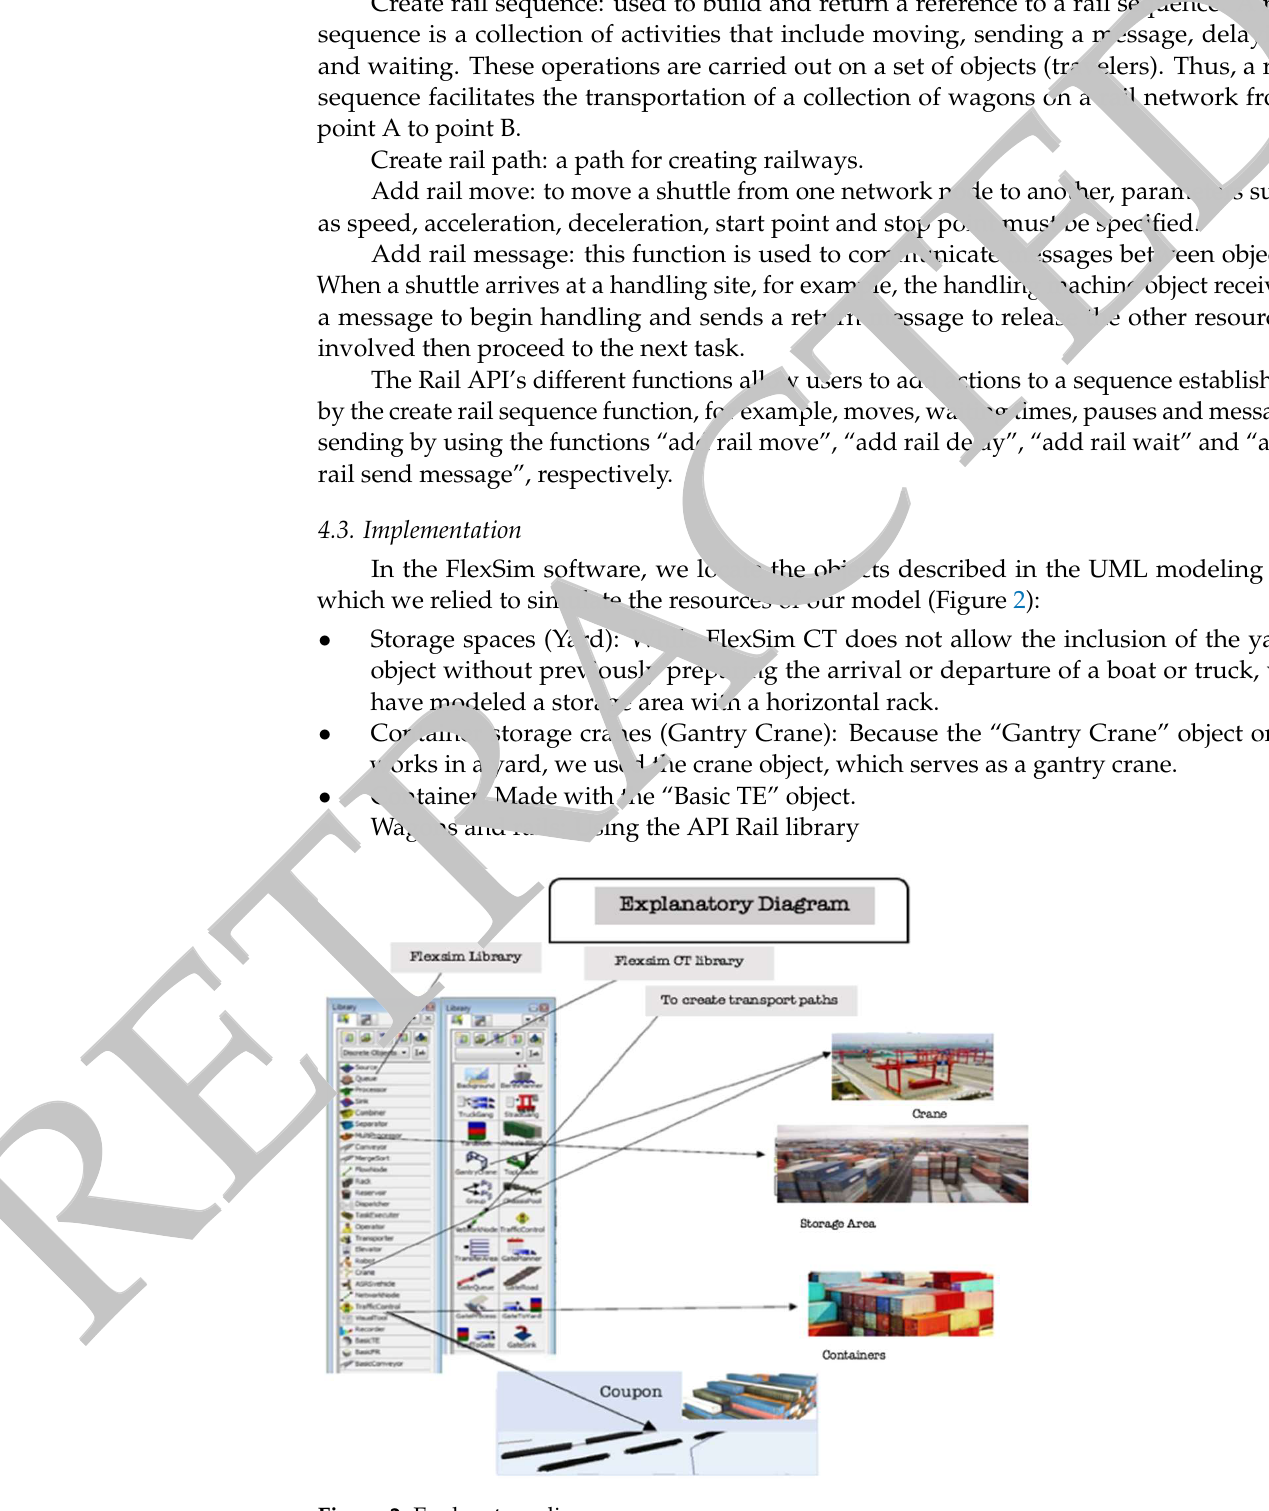
Figure 2. Explanatory